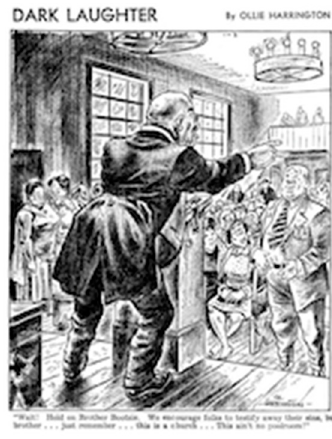
Figure 9. Black preacher as seen in newspaper comic strip. Dark Laughter, 1947. 18 (Cooper 2017); (Corbould 2011). 19 (Jackson 2016, p. 8); (Suggs 1983); (Gordon